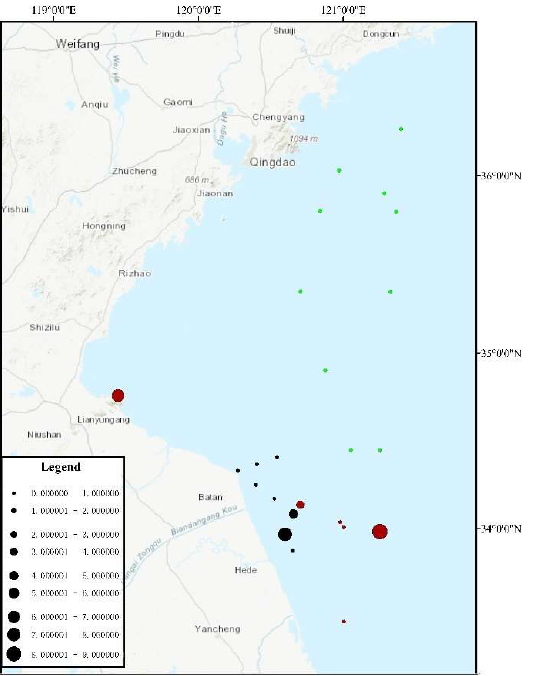
Figure 3. Percrntage of U. aragoensis in the floating green macroalgae. Circle size represents the proportion of U. aragoensis . Different colors represent different sample collection times. Red represents samples collected from 6 May 2021 to 9 May 2021, black represents samples collected from 14 May 2021 to 16 May 2021, and green represents samples collected from 15 July 2021 to 18 July 2021.